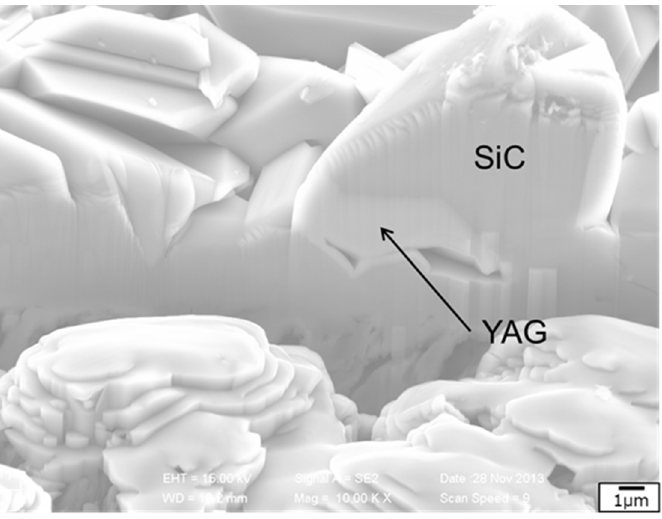
Figure 6. A SEM image of the LPS SiC following high-temperature water corrosion (8 ppm dissolved oxygen, 20 MPa, 360 °C, and 168 h).